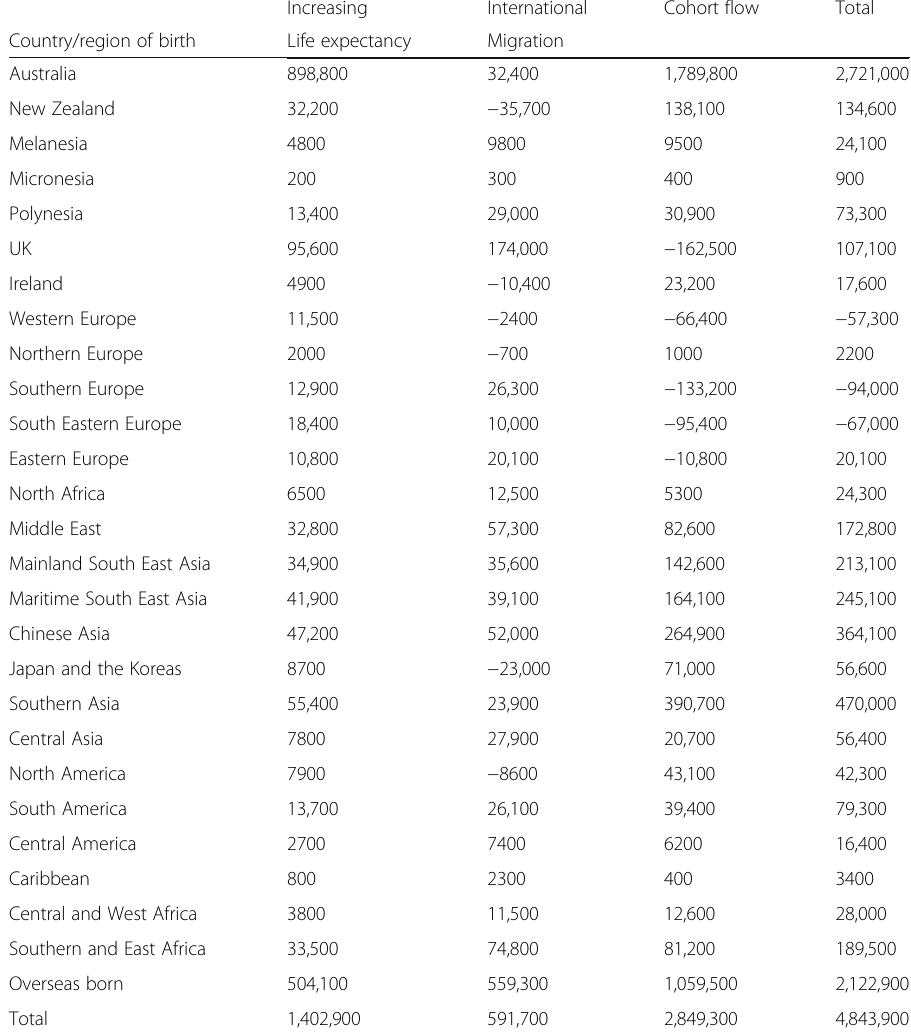
Table 3 The demographic drivers of population change for ages 65+ by main birthplace category, 2016-2056 Increasing Country/region of